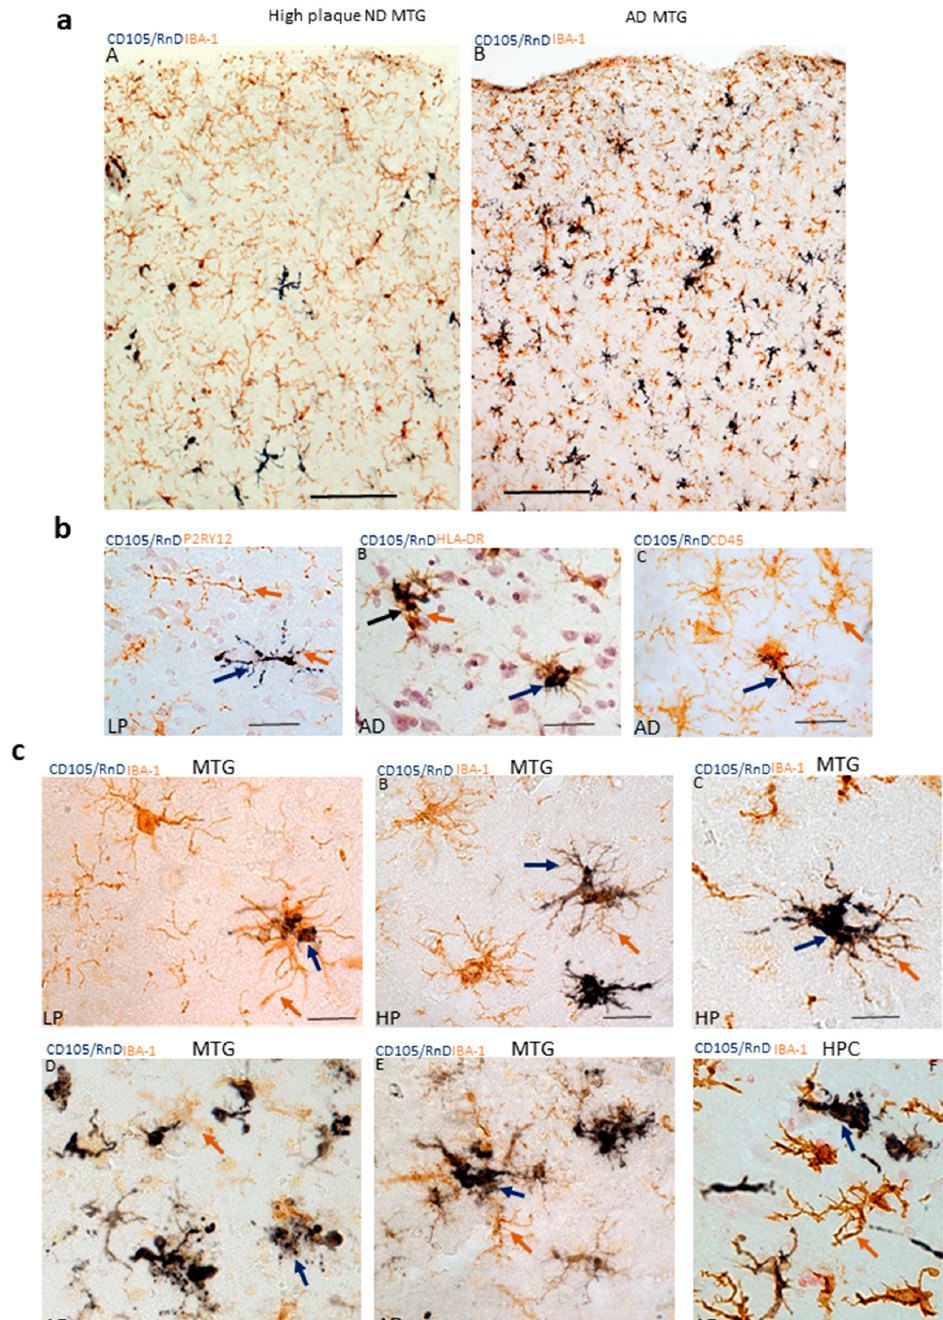
Figure 4. Images demonstrating colocalization of CD105 / MAB1097 with microglial markers ( a ) panels A, B Low magnification images of high-plaque (HP) case (panel A) and AD case (panel B) showing staining with CD105 / MAB1097 (purple arrows) and IBA-1 (brown arrows) in MTG sections. Both images at same magnification: scale bars represent 100 µ m. ( b ) (panel A) CD105 microglia (purple arrows) with ramified morphology stained with antibody to P2RY12 (brown arrow) in low-plaque (LP) case. (panel B) CD105 microglia (purple arrows) and HLA-DR (brown arrow) in AD case. (panel C) CD105 microglia (purple arrow) and CD45 (brown arrow) in AD case. All sections were from MTG. Images at same magnification: scale bars represent 50 µ m. ( c ) (panel A–E). Patterns of staining of CD105 (purple) and IBA-1 (brown) in MTG sections of cases with progressively increasing pathology from LP to AD. (panel F). CD105-positive microglia in hippocampus (HPC) of AD case. Images at same magnification: scale bars represent 50 µ